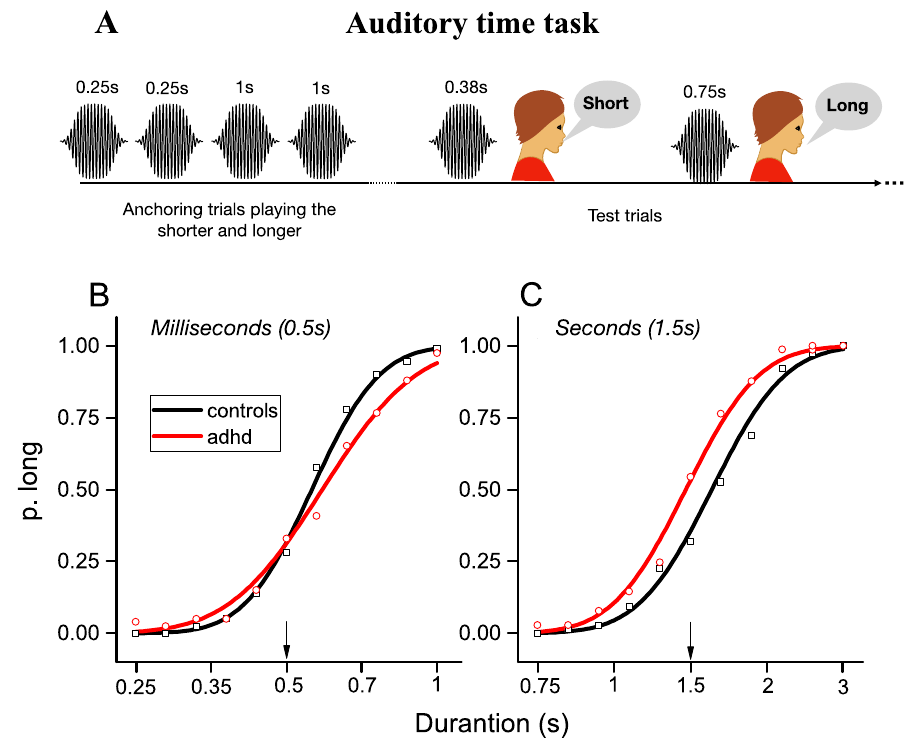
Figure 1. ( A ) A block consisted of four initial “anchoring” trials in which the shorter (0.25 s or 0.75 s depending on the condition) and the longer (1 s or 3 s depending on the condition) stimuli were presented (participants were told that those sounds correspond to the range extremes). After this phase, the testing phase started, and participants were asked to categorize as “long or short” a sound randomly drawn from a pre-defined distribution. ( B , C ) Psychometric functions (aggregate data) for controls (black, squares) and participants with ADHD (red, circles) for the milliseconds ( B ) and seconds ( C ) ranges.